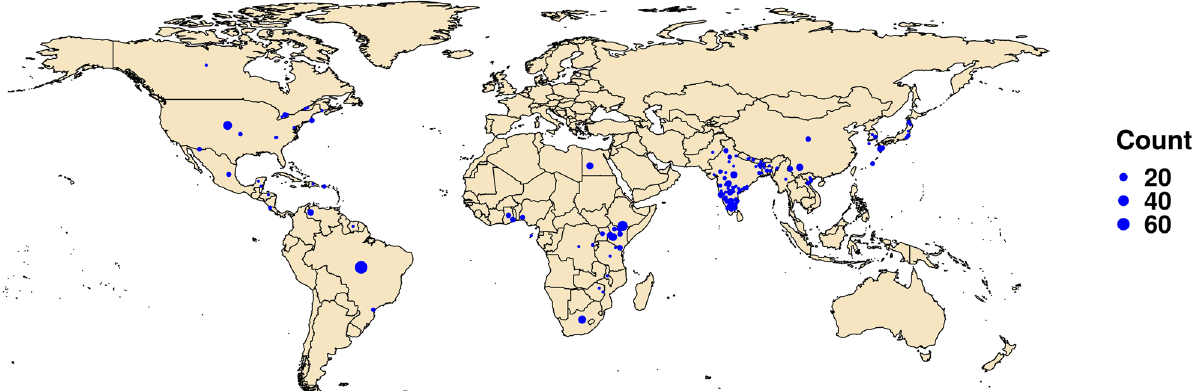
Figure 1. Locations of the FAW samples analysed in this study. The size of the dot is indicative of the number of samples analysed from that location. The map was drawn using R package rworldmap v 1.3.6 and tidyverse v 1.3.0 23,24